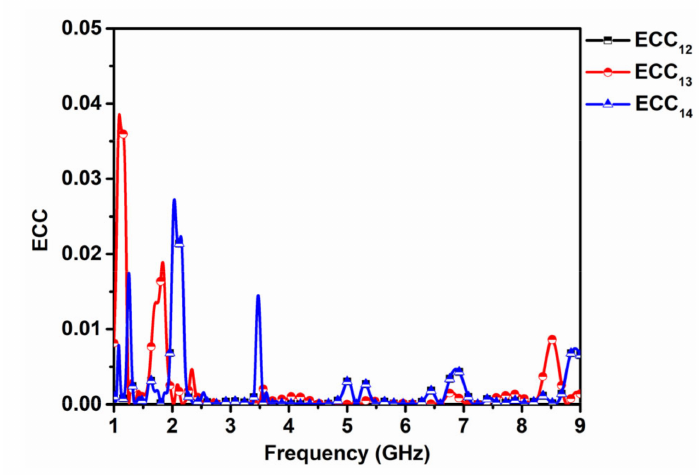
Figure 8. ECC of the quad-port antenna.